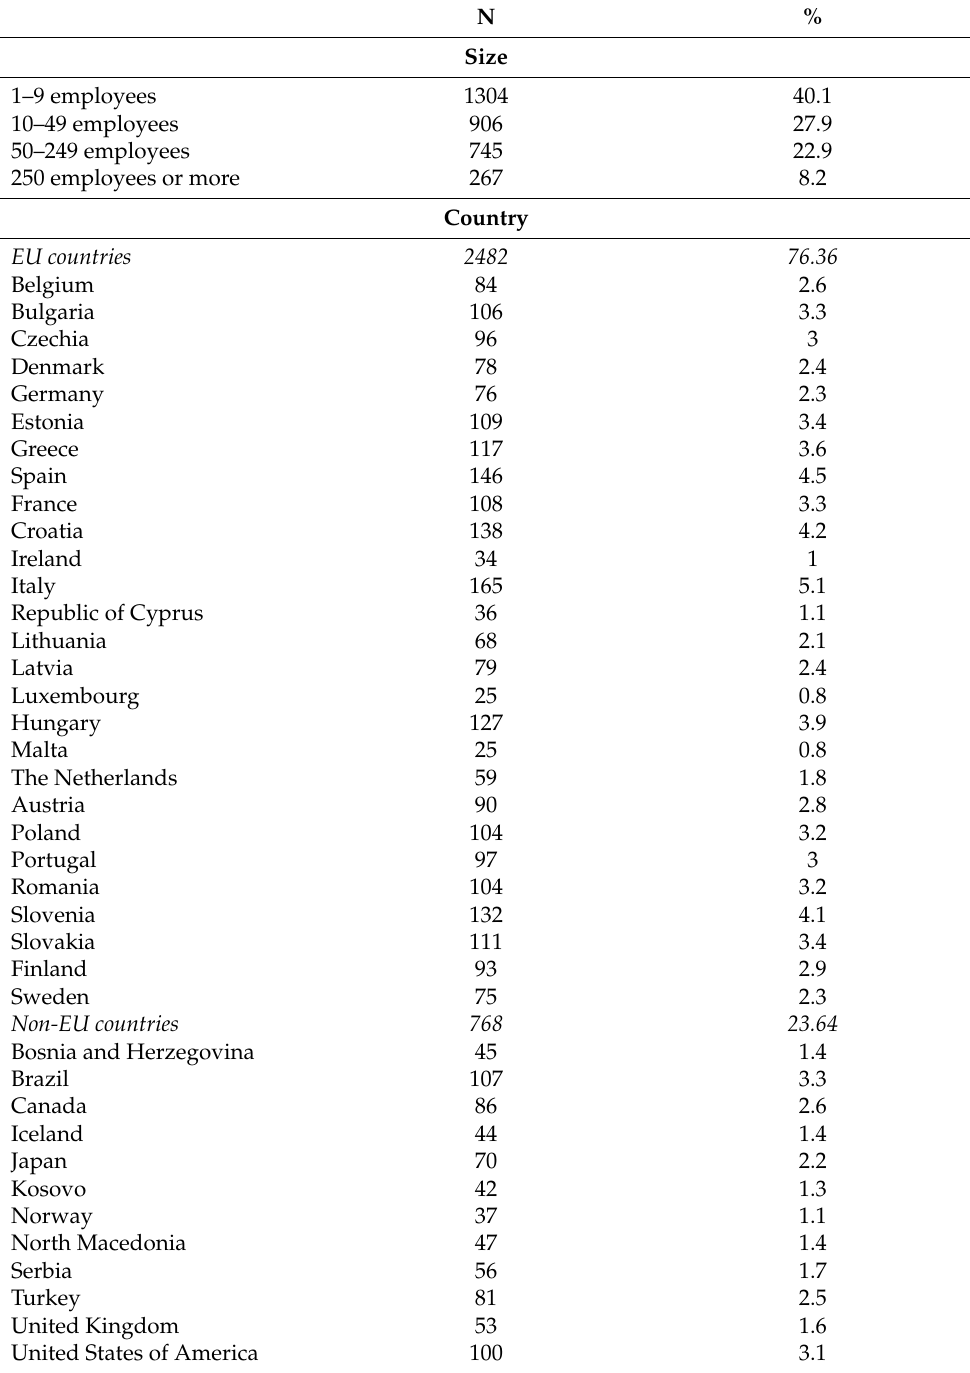
Table 1. Sample distribution (N = 3250 manufacturing